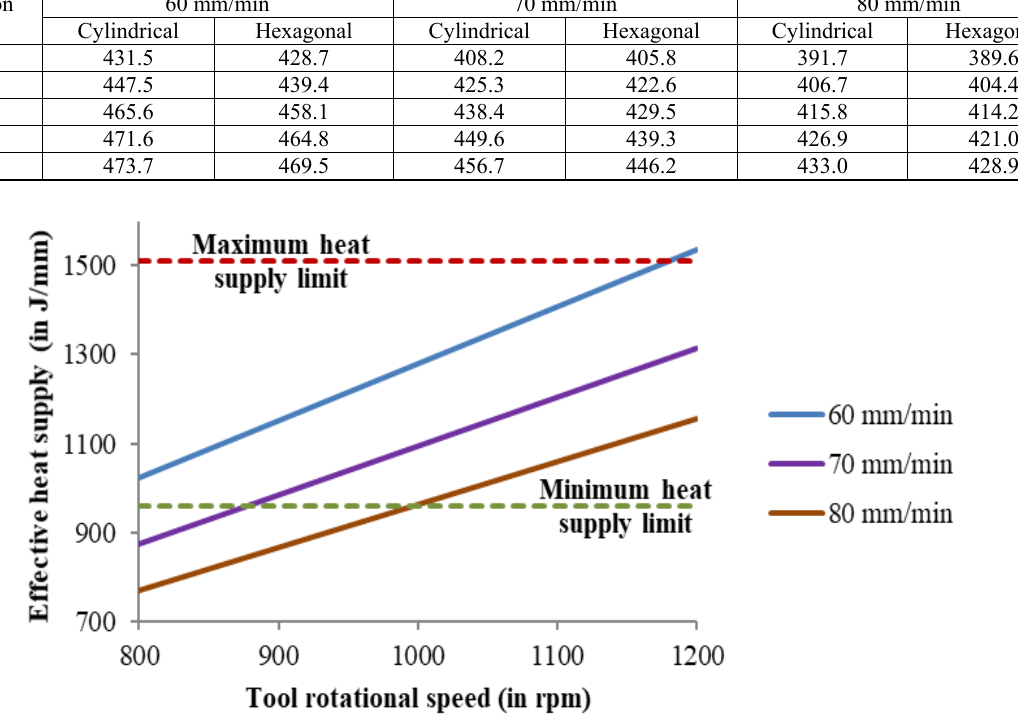
Figure 3 . Optimum effective heat supply (cylindrical pin)